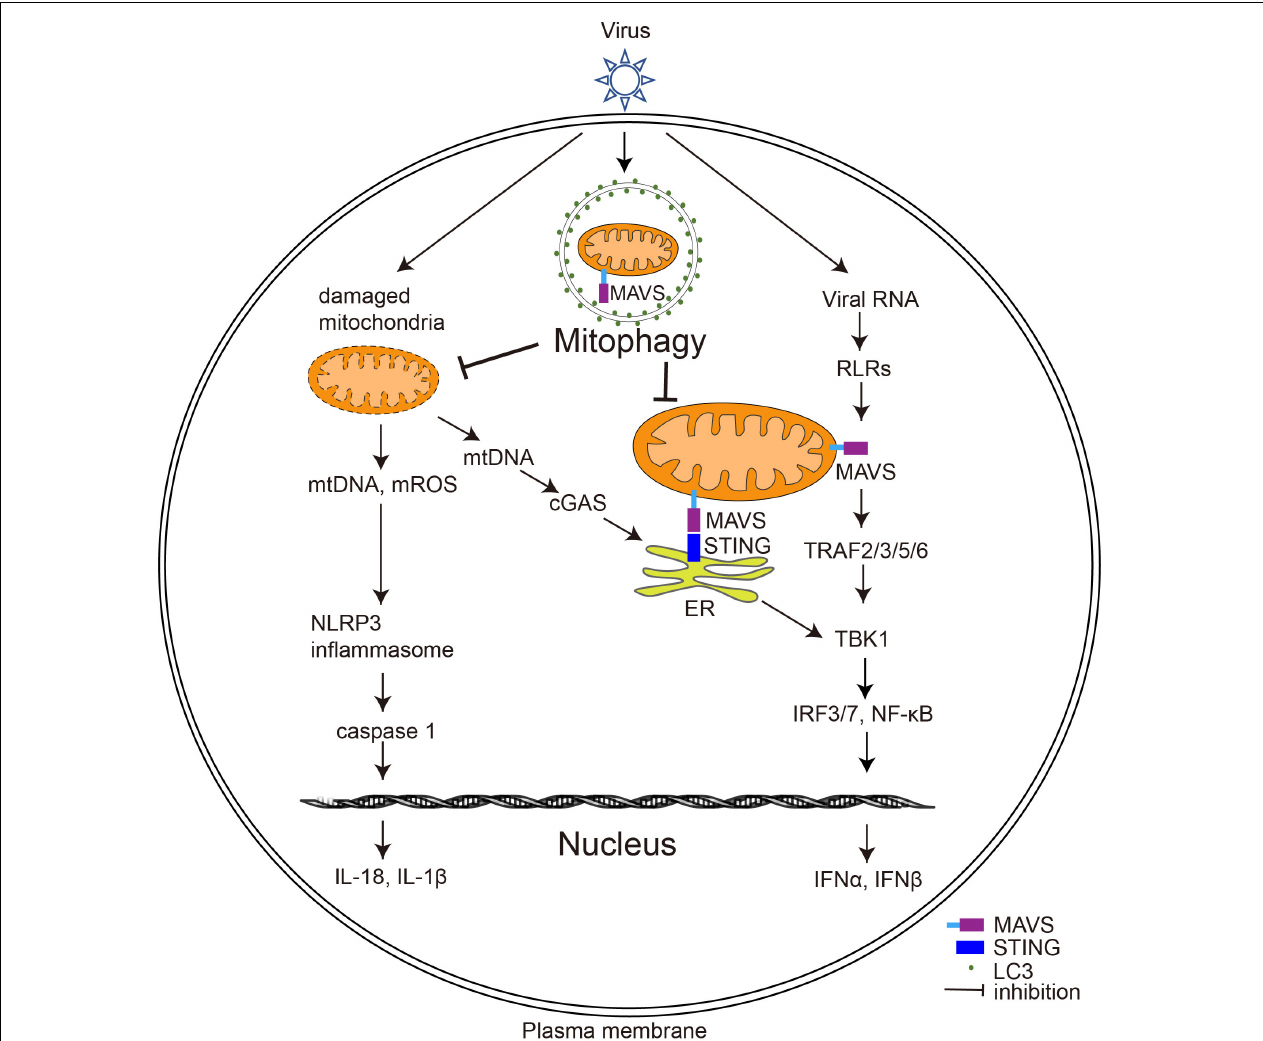
FIGURE 3 | The effect of virus-induced mitophagy on the host immune system. Upon viral infection, RLRs (including MDA5 and RIG-I) on the host cell surface sense viral RNA and induce MAVS to form prion-like aggregates, which further trigger type I IFN production. Virus-induced mitophagy leads to the degradation of MAVS, thereby weakening the type I IFN response of the host. Furthermore, virus-induced mitophagy also removes damaged mitochondria to inhibit the activation of cGAS-STING signaling pathways and the inflammasome; ER, endoplasmic reticulum; mROS, mitochondrial ROS.